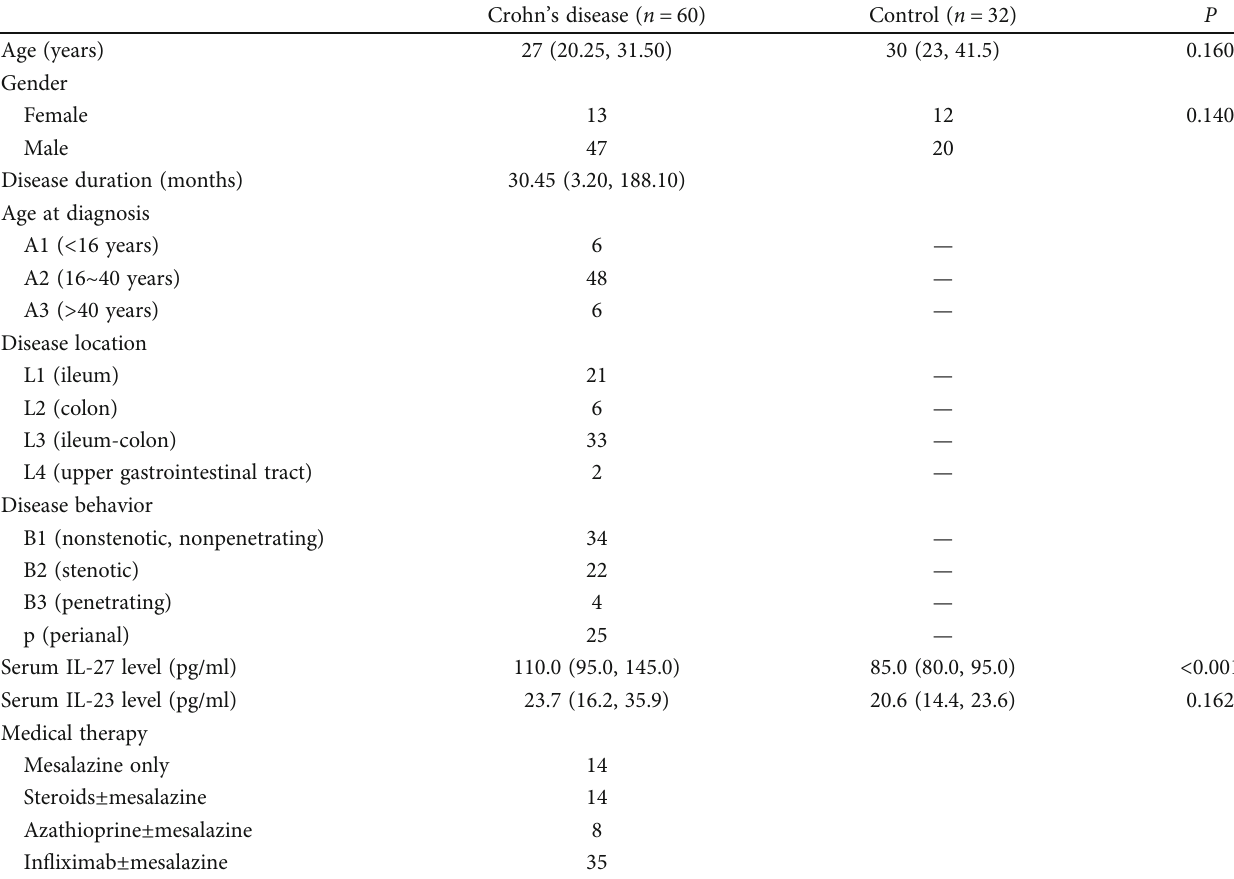
Table 1: Clinical characteristics of the CD patients and control